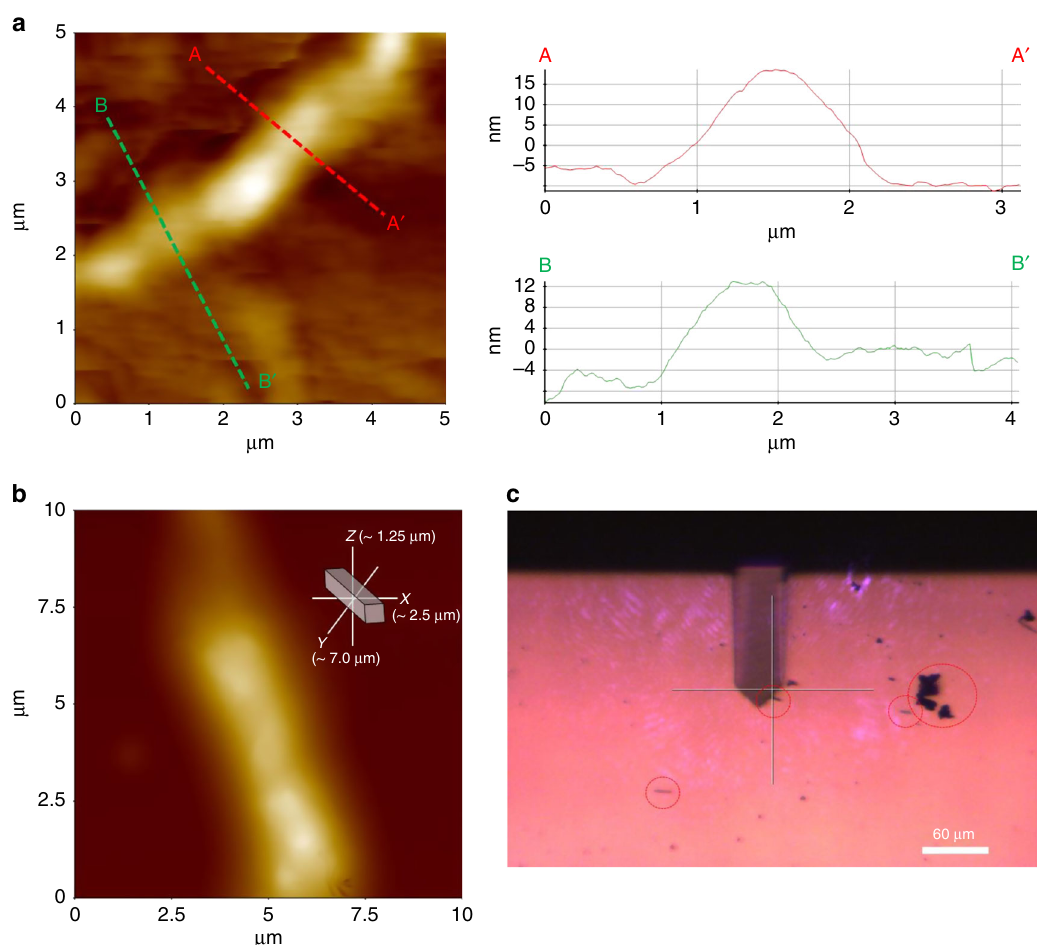
Fig. 6 AFM images of isolated 1D Si-nanowires. a Si-NS9.3_21 GPa and its 1-dimensional height pro fi le sections. b Another AFM image of Si-NS9.3_21 GPa with its dimension. c Optical image of nanowires (circled) dispersed on a glass substrate (Park Systems,